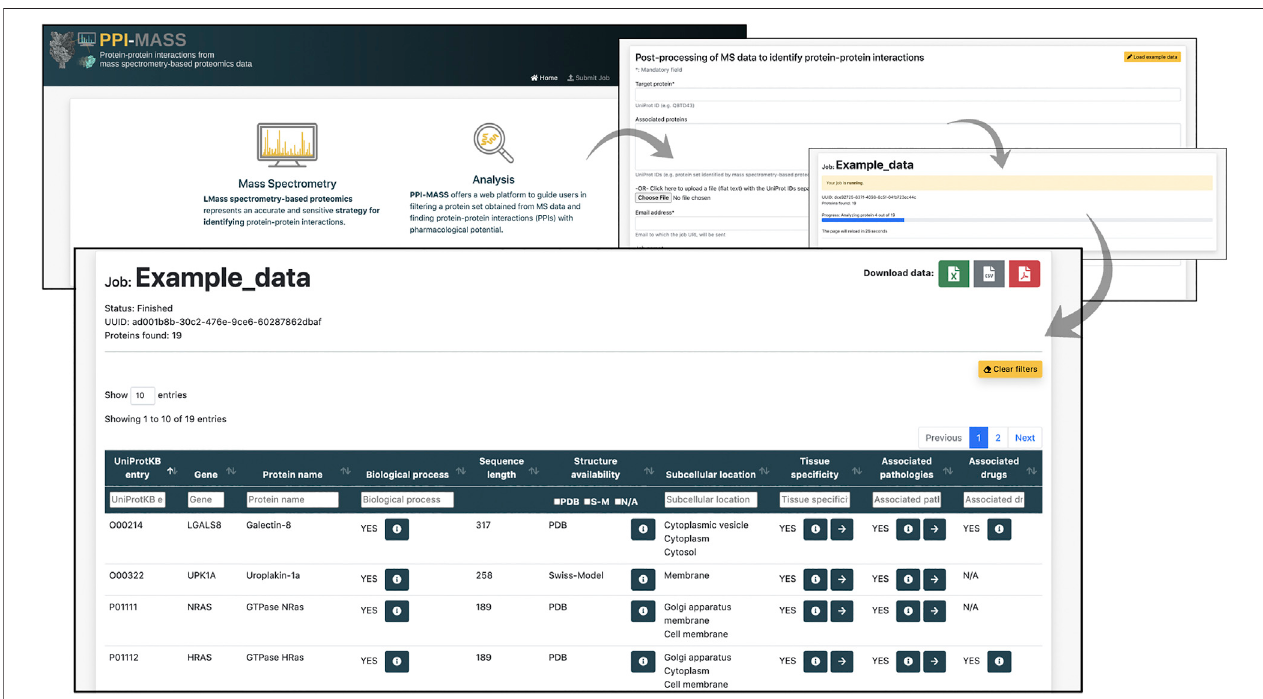
FIGURE 2 | Representative example of a job processed through the PPI-MASS web server. The result page includes an interactive table with ten fi elds that allow the users fi ltering aprotein set according to different parameters ofinterest.The buttons allow toexpand theresults into amodal dialogue box or provide access links to the databases used as